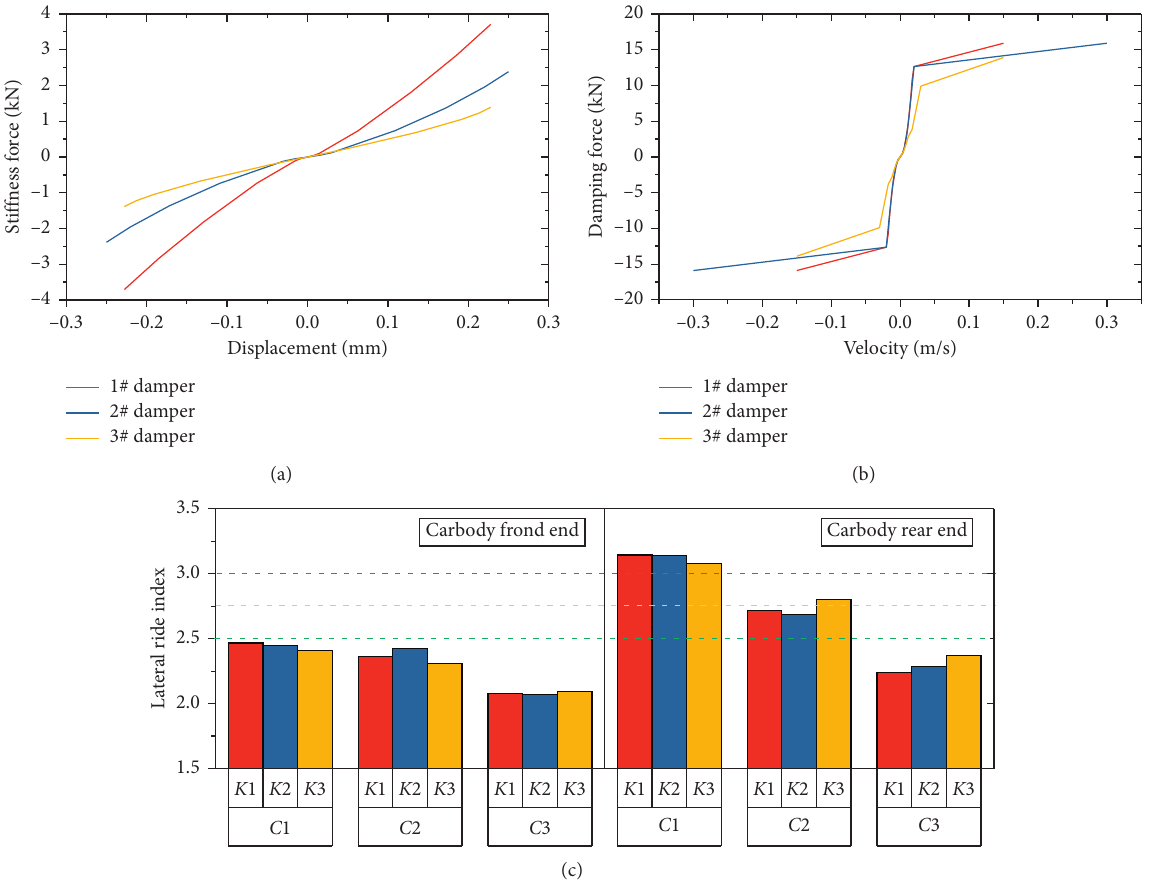
Figure 13: Parameter characteristic of yaw damper. (a) Damping characteristic, (b) stiffness characteristic, and (c) the optimized effect on lateral ride index by yaw damper.